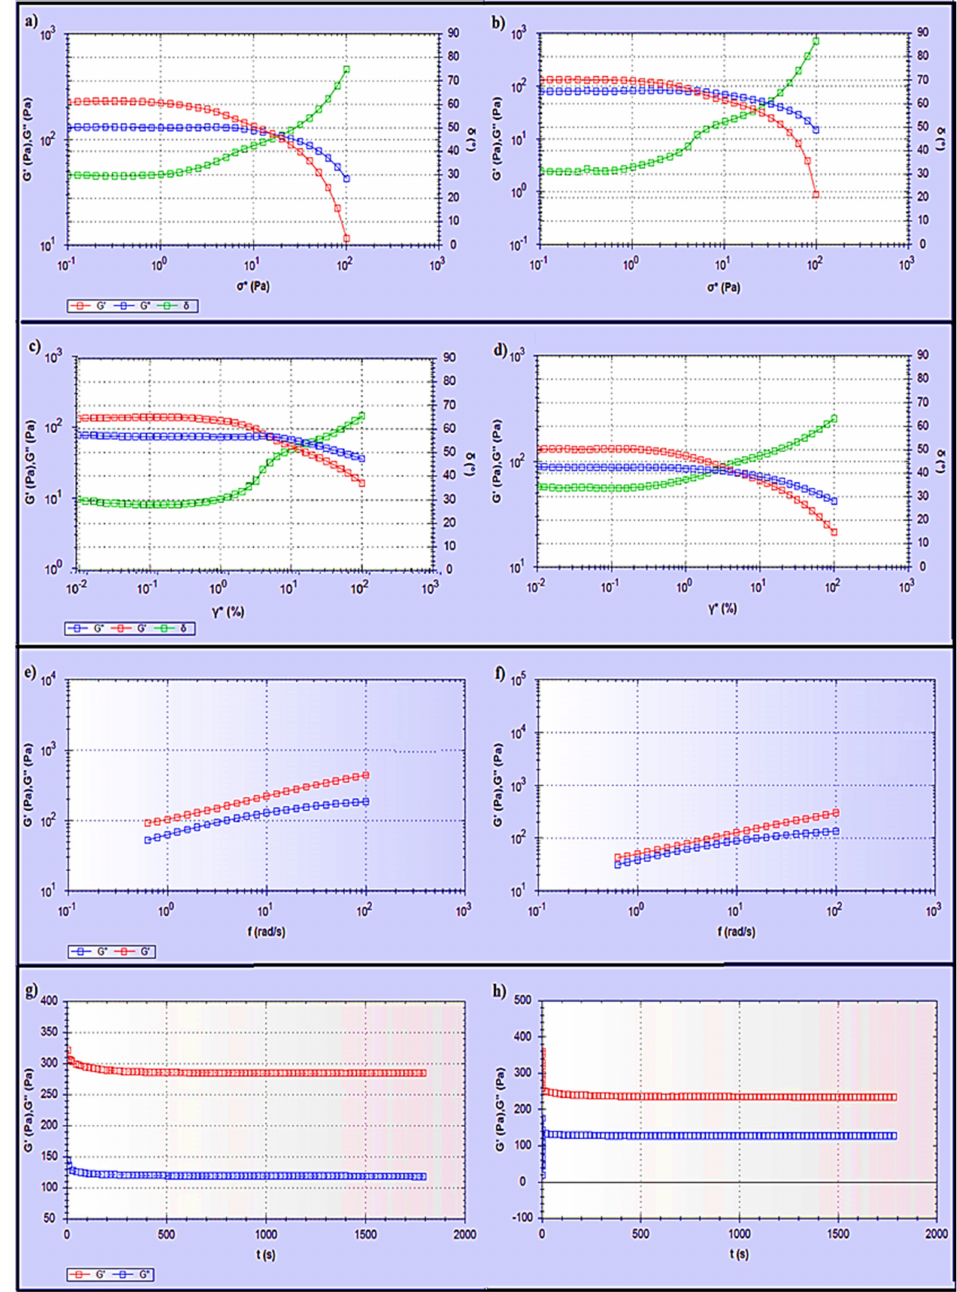
Figure 7. Rheological study of ( a ) stress sweep test for S3, ( b ) stress sweep test for S6, ( c ) dynamic strain sweep test for S3, ( d ) dynamic strain sweep test for S6, ( e ) dynamic frequency sweep test for S3, ( f ) dynamic frequency sweep test for S6, ( g ) dynamic time sweep test for S3, ( h ) dynamic time sweep test for